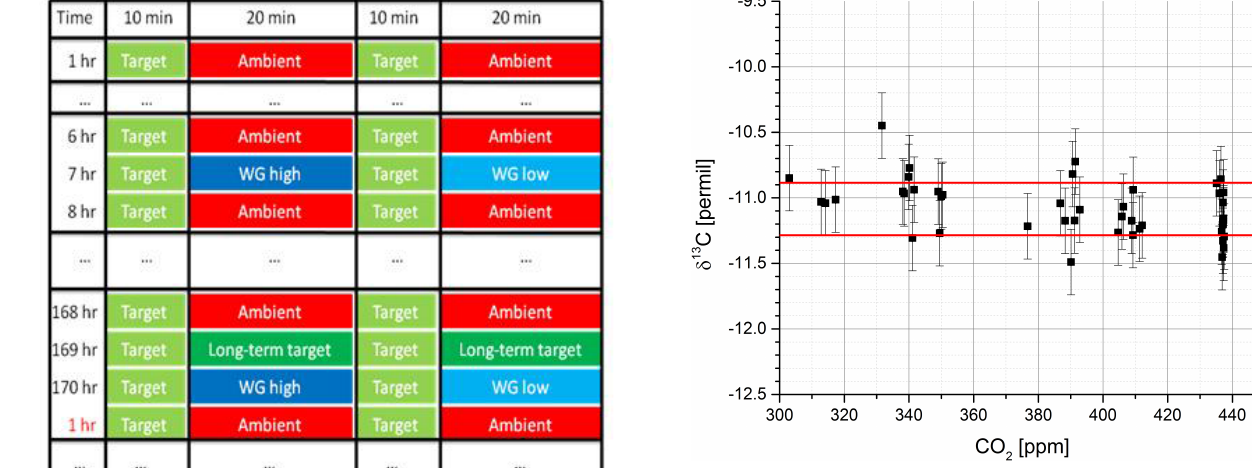
Fig. 5. Dilution experiment using two gas streams to vary the CO 2 concentration while maintaining a constant δ 13 C to infer potential CO 2 concentration